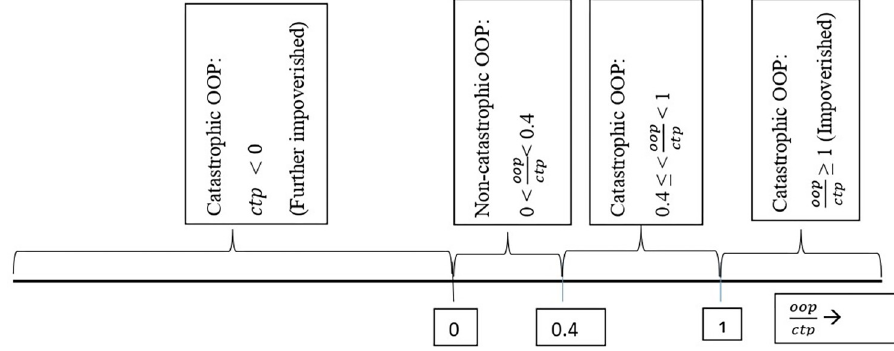
Fig 2. Out-of-pocket health expenditure as a fraction of capacity-to-pay, and catastrophic health expenditure. ctp = capacity-to-pay, oop = out-of-pocket payment.